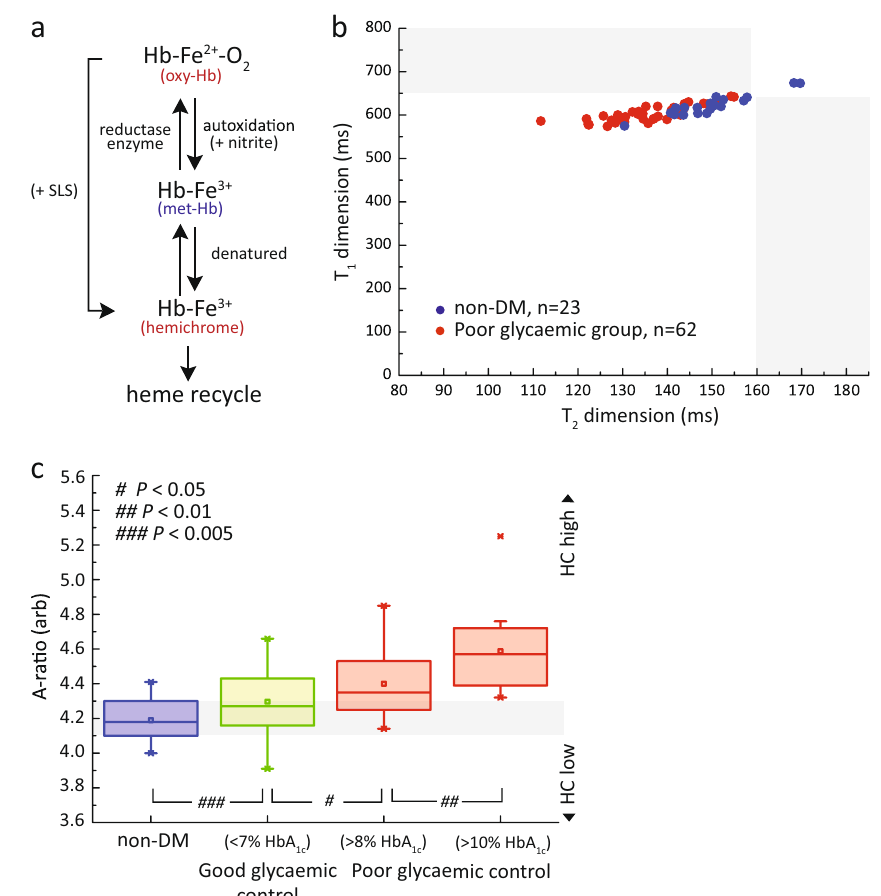
Fig. 3 Baseline measurements of oxidative stress in RBCs. a In vivo redox oxidation produces denatured Hb, known as the low-spin hemichrome (HC). HC can be chemically induced using sodium salicylate (SLS) in in vitro environment. b The T 1 – T 2 relaxometry coordinates of RBCs baseline readings of non-DM subjects (blue, n = 23) and subjects with poor glycaemic control (red, n = 68). c Baseline readings of RBCs samples with A-ratio index of subjects with poor glycaemic controls ( n = 62) and good glycaemic control ( n = 50) subgroup as compared to healthy non-DM subjects ( n = 20). The subjects with poor glycaemic controls were further subdivided into >8% HbA 1c ( n = 47) and >10% HbA 1c ( n = 15) subgroups. The A-ratio for the subgroups were in increasing trends for non-DM to DM due to increasing formation of HC (Supplementary Fig. 4). The statistical signi fi cance was calculated using the Student ’ s T-test (two-tailed, unequal variance). The data is represented by box-plot